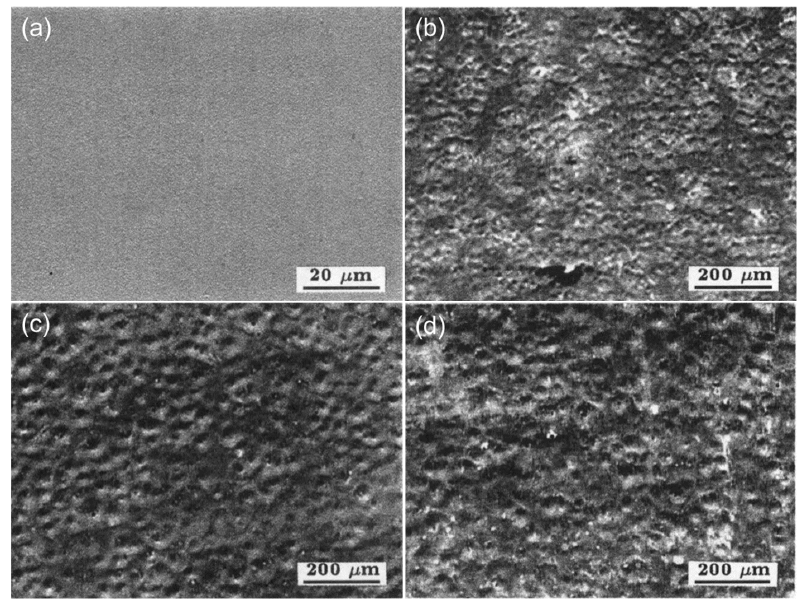
Figure 4. SEM images of the surfaces of HSS ( a ) non-irradiated; ( b ) irradiated with 1 pulse; ( c ) irra- diated with 3 pulses; ( d ) irradiated with 5 pulses showing the crater formation after irradiation by HIPIB [49].